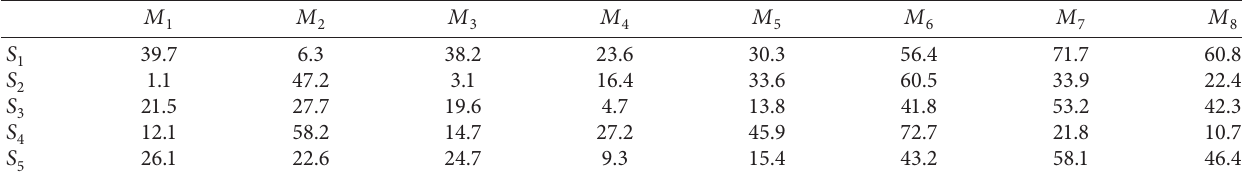
Table 3: Distance between sites.